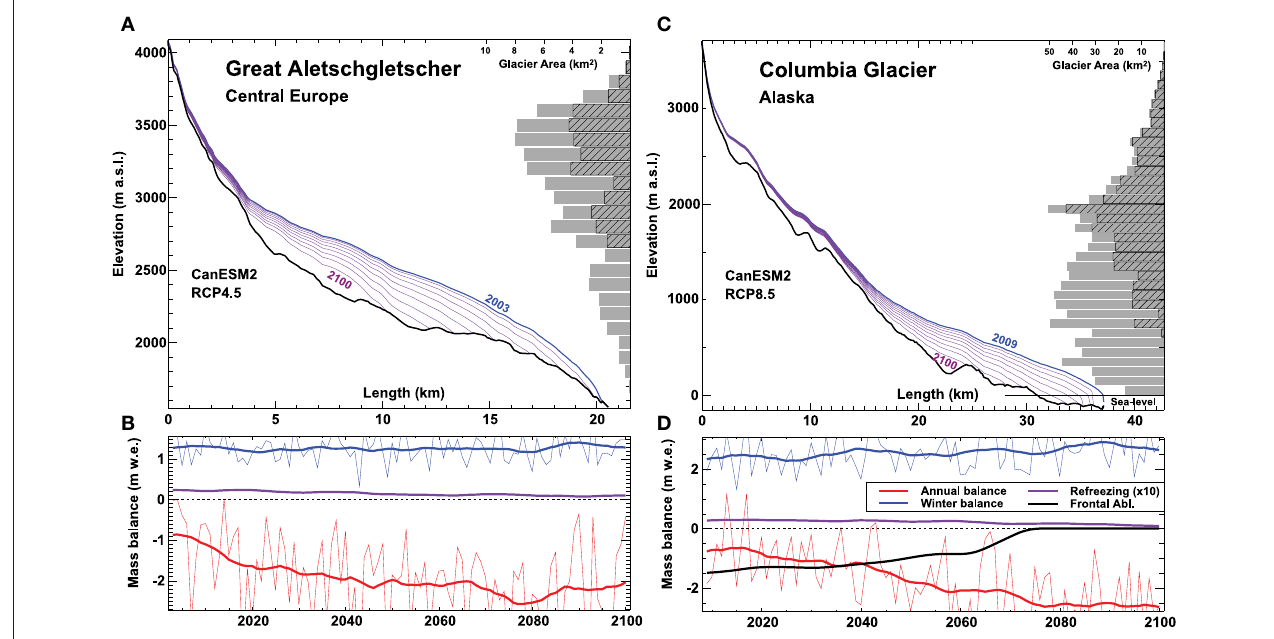
FIGURE 1 | Modeled retreat of (A) Great Aletschgletscher (land-terminating), Central Europe, and (C) Columbia Glacier (tide-water glacier), Alaska, according to the CanESM2 GCM and RCP4.5/RCP8.5. Calculated glacier surfaces are shown in 10-year intervals. Area-elevation distribution in 100m bins is shown for today (gray) and 2100 (hatched). (B,D) Temporal evolution of mass balance components. Yearly values of annual and winter surface balance are shown as thin lines. Thick lines refer to 11-year running means. Note that refreezing is enlarged by a factor